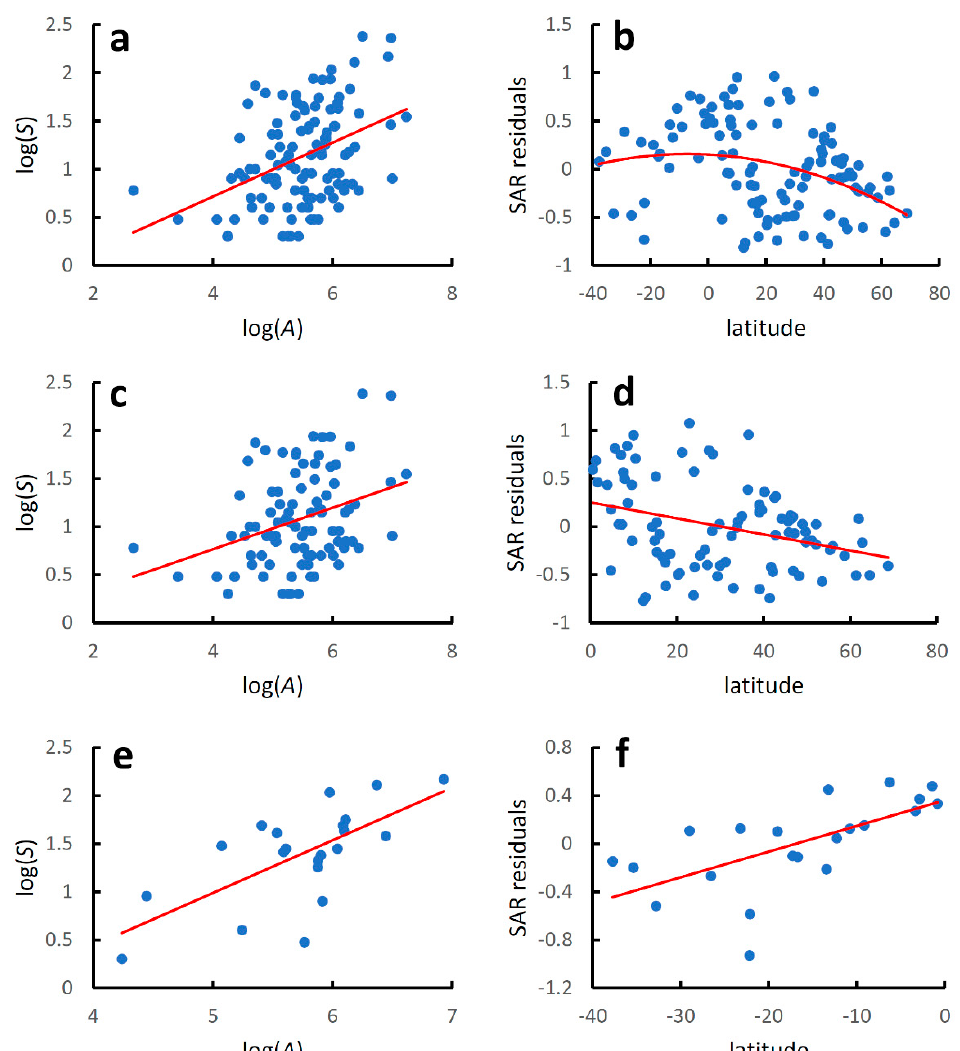
Figure 2. Earwig species–area relationships and latitudinal diversity gradients for world mainland countries. Species–area relationships were modelled using the linearized version of the power function: log( S ) = z log( A ) + log( c ), where S is the recorded species richness at country level, A is country area (km 2 ), and z and c are estimated parameters. Latitudinal gradients were modelled with regressing residuals from the species–area relationships (SAR residuals) against country latitude with a second-order polynomial regression for the whole dataset and with linear regressions for the two hemispheres separately. ( a ) Global species–area relationship; ( b ) global latitudinal gradient; ( c ) species–area relationship for the Northern Hemisphere; ( d ) latitudinal gradient for the Northern Hemisphere; ( e ) species–area relationship for the Southern Hemisphere; ( f ) latitudinal gradient for the Southern Hemisphere. Regression equations are given in Table 2.